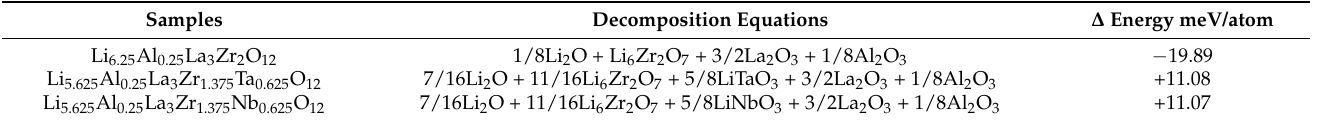
Table 2. The simulated thermodynamic stability of Al-LLZO, Al-LLZTO, and Al-LLZNO. Samples Decomposition